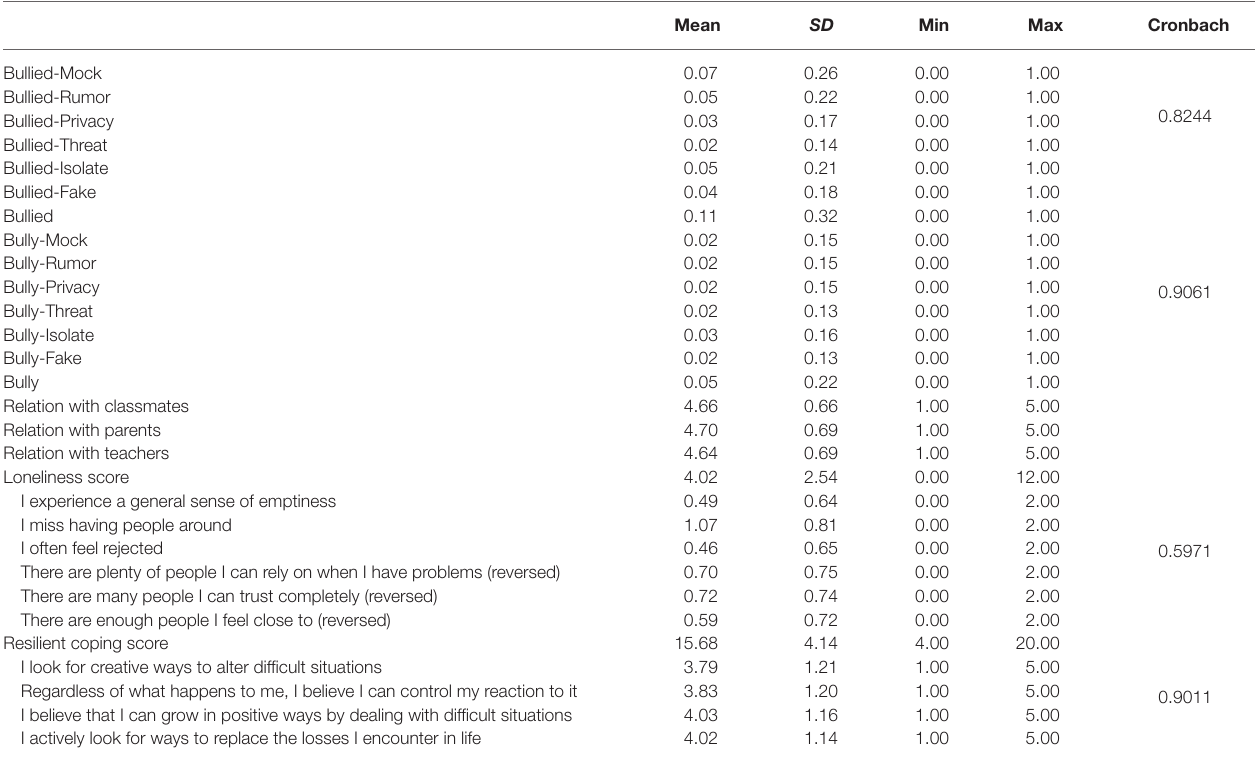
TABLE 1 | Cyberbullying involvement and